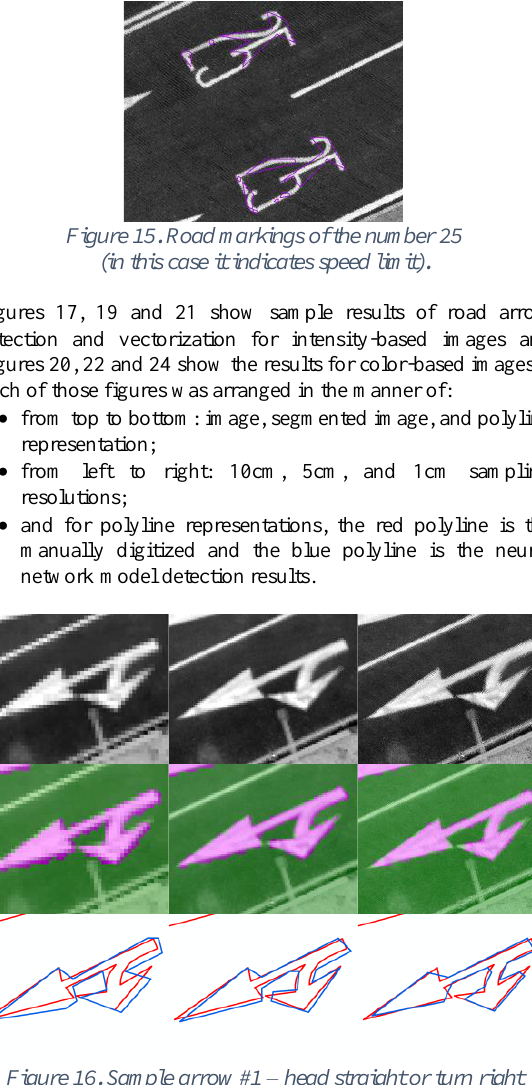
Figure 16. Sample arrow #1 – head straight or turn right (intensity-based).